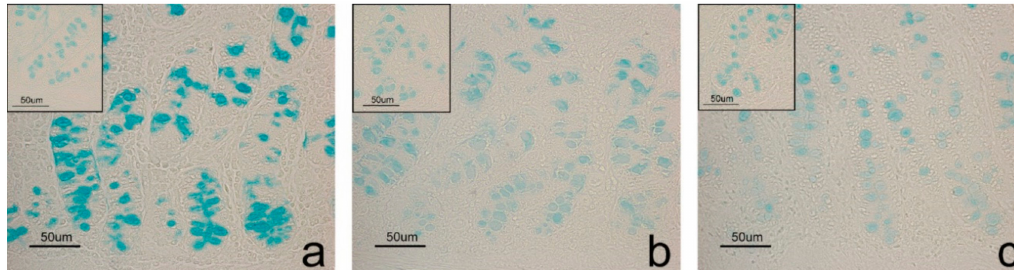
Figure 1. Mucosal duodenum sections derived from EXP samples. Images show di ff erentiated AB reactivity ( a ) of goblet cells induced by Sial-AB ( b ) and KOH-Sial-AB ( c ) histochemical treatments